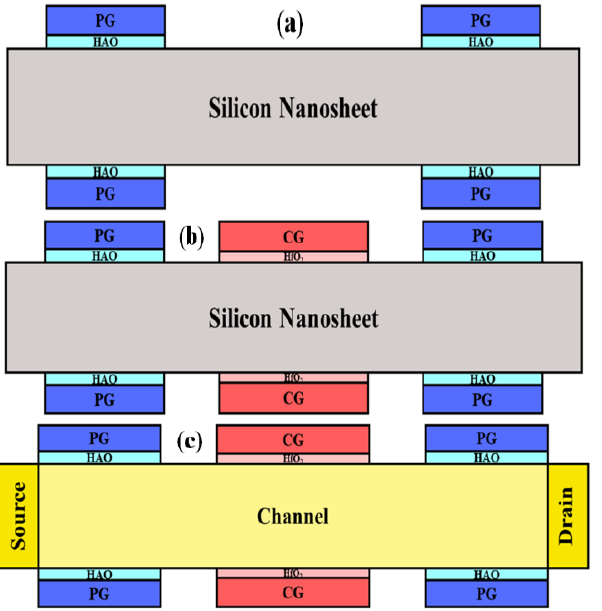
Figure 2. Fe-ED NSTFET fabrication steps: ( a ) polarity gate, ( b ) self-aligned control gate, and ( c ) S/D contacts.